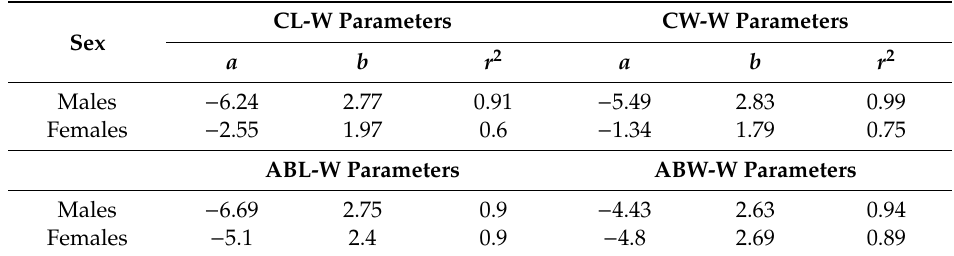
Table 5. CL–W, carapace width (CW)–W, abdomen length (ABL)–W, and abdomen width (ABW)–W relationship parameters, after log-transformation of the Thermaikos Gulf spiny lobsters (2017). CL-W Parameters Sex